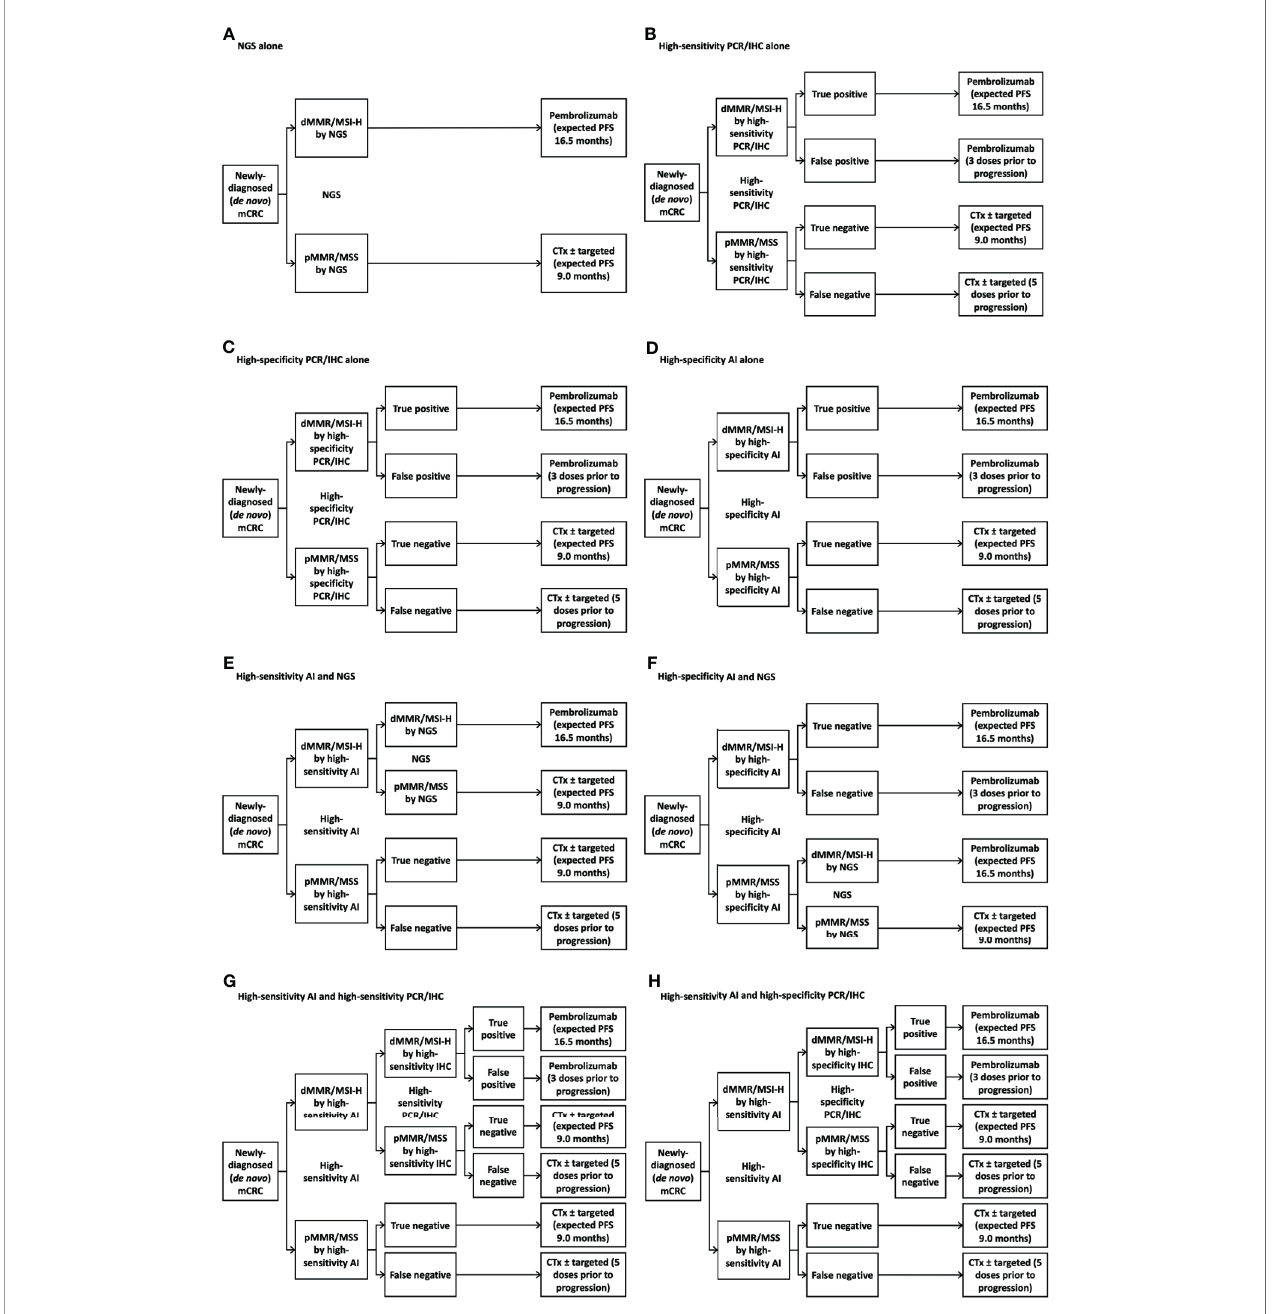
FIGURE 1 | Treatment decision tree with various testing strategies. (A) Next-generation sequencing alone; (B) High-sensitivity immunohistochemistry panel alone; (C) High-speci fi city immunohistochemistry panel alone; (D) High-speci fi city arti fi cial intelligence alone; (E) High-sensitivity arti fi cial intelligence followed by next- generation sequencing for individuals with de fi cient mismatch repair/microsatellite instability-high tumors by arti fi cial intelligence; (F) High-speci fi city arti fi cial intelligence followed by next-generation sequencing for individuals with intact mismatch repair/microsatellite stable tumors by arti fi cial intelligence; (G) High-sensitivity arti fi cial intelligence followed by high-sensitivity immunohistochemistry panel for individuals with de fi cient mismatch repair/microsatellite instability-high tumors by arti fi cial intelligence; (H) High-sensitivity arti fi cial intelligence followed by high-speci fi city immunohistochemistry panel for individuals with de fi cient mismatch repair/ microsatellite instability-high tumors by arti fi cial intelligence. AI, arti fi cial intelligence; CTx, chemotherapy; dMMR, de fi cient mismatch repair; FU, fl uorouracil; IHC, immunohistochemistry; mCRC, metastatic colorectal cancer; MSI-H, microsatellite instability-high; MSS, microsatellite-stable; NGS, next-generation sequencing; PCR, polymerase chain reaction; PFS, progression-free survival; pMMR, pro fi cient mismatch